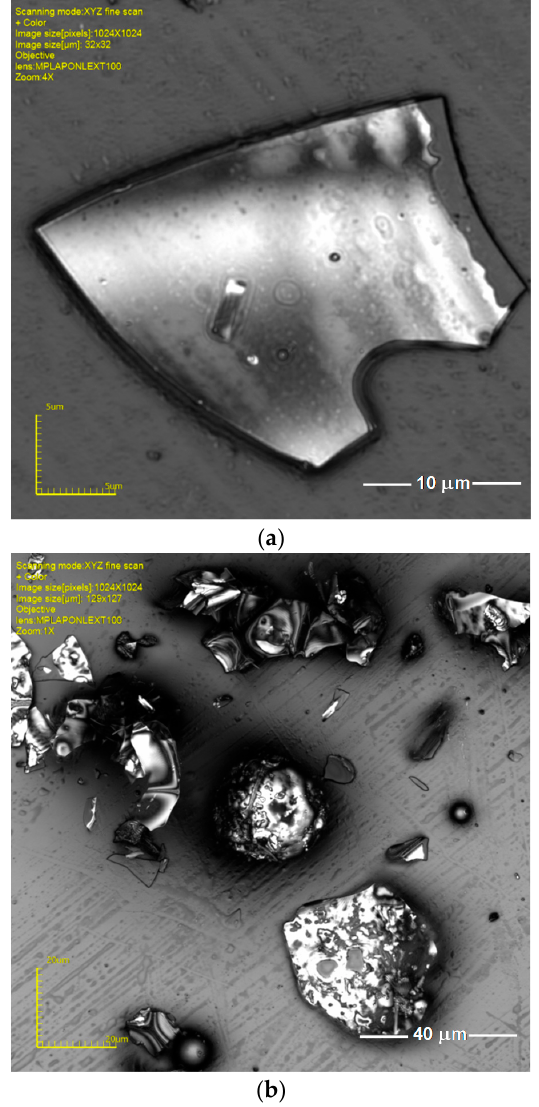
Figure 2. Typical shapes of the waste perlite powder grains; images from a laser optical microscope. ( a ) Single flat particle; ( b ) particles of irregular shapes.